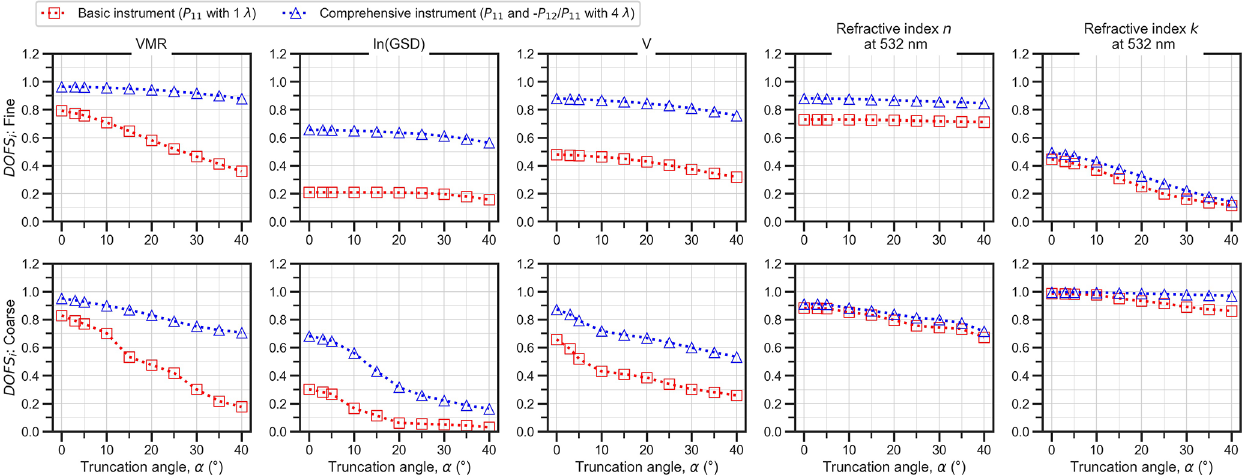
Figure 7. Variation in DOFS i for unimodal, non-absorbing-aerosol test cases over different extreme-angle truncation cases. The top row demonstrates the results for the fine-aerosol test case, while the bottom row corresponds to results for the coarse-aerosol test case. These results were obtained using default measurement noise values and the “high level of prior knowledge” method for selecting a priori